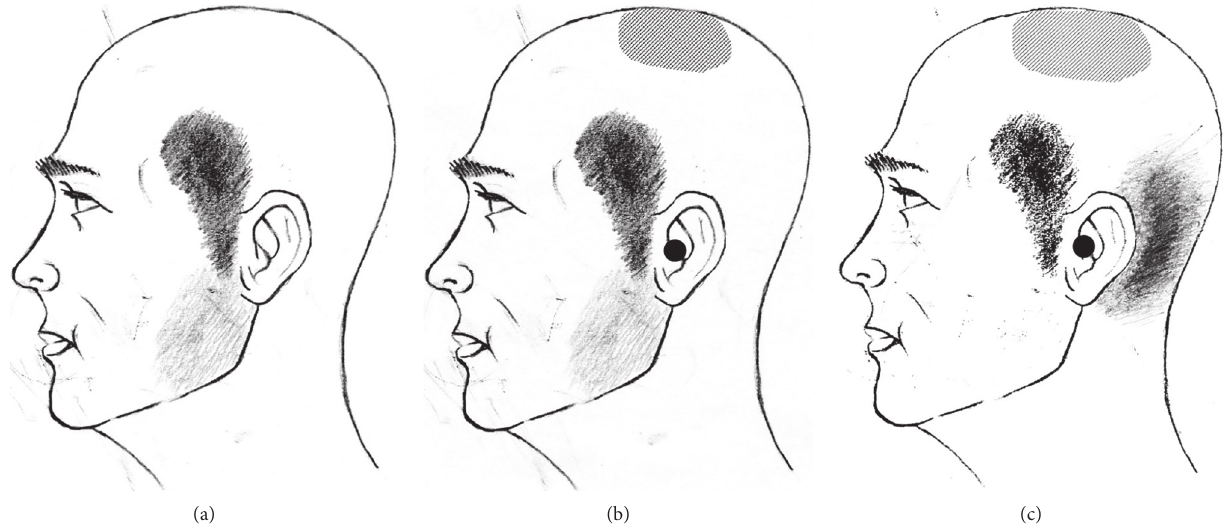
Figure 1: Schematic diagram demonstrating the distribution and characteristics of pain over the years. (a) The gray areas over the left preauricular temporal area indicate the distribution of paroxysmal lancinating pain that started in 2014. Pain initially began as a persistent aching pain in the left molars and gums (light gray area). (b) In 2016, paroxysmal pain occurred in the left preauricular temporal region, and at the same time in the left vertex (obliquely hatched area) and the left deep ear (black circle). (c) It was not until 2018, four years after the occurrence of paroxysmal pain, that the stabbing pain in the retroauricular occipital area (transversely hatched area) occurred as pain in the left temporal region (gray area), left vertex (obliquely hatched area), and left deep ear (black